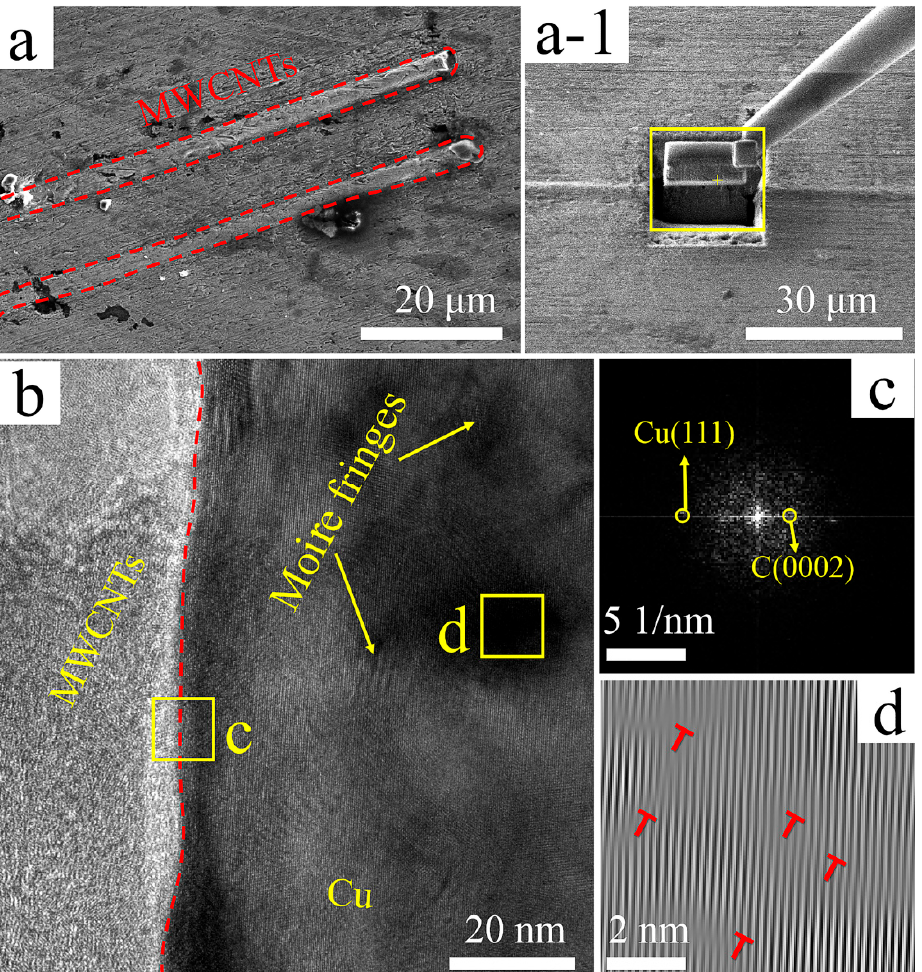
Figure 2. ( a ) SEM micrograph of B-MWCNTs/Cu composite, ( a-1 ) Sampling the manipulator at a, ( b ) TEM micrograph, ( c ) FFT image of region c in b, ( d ) IFFT image of region d in b, dislocations marked with ‘T’ symbols.